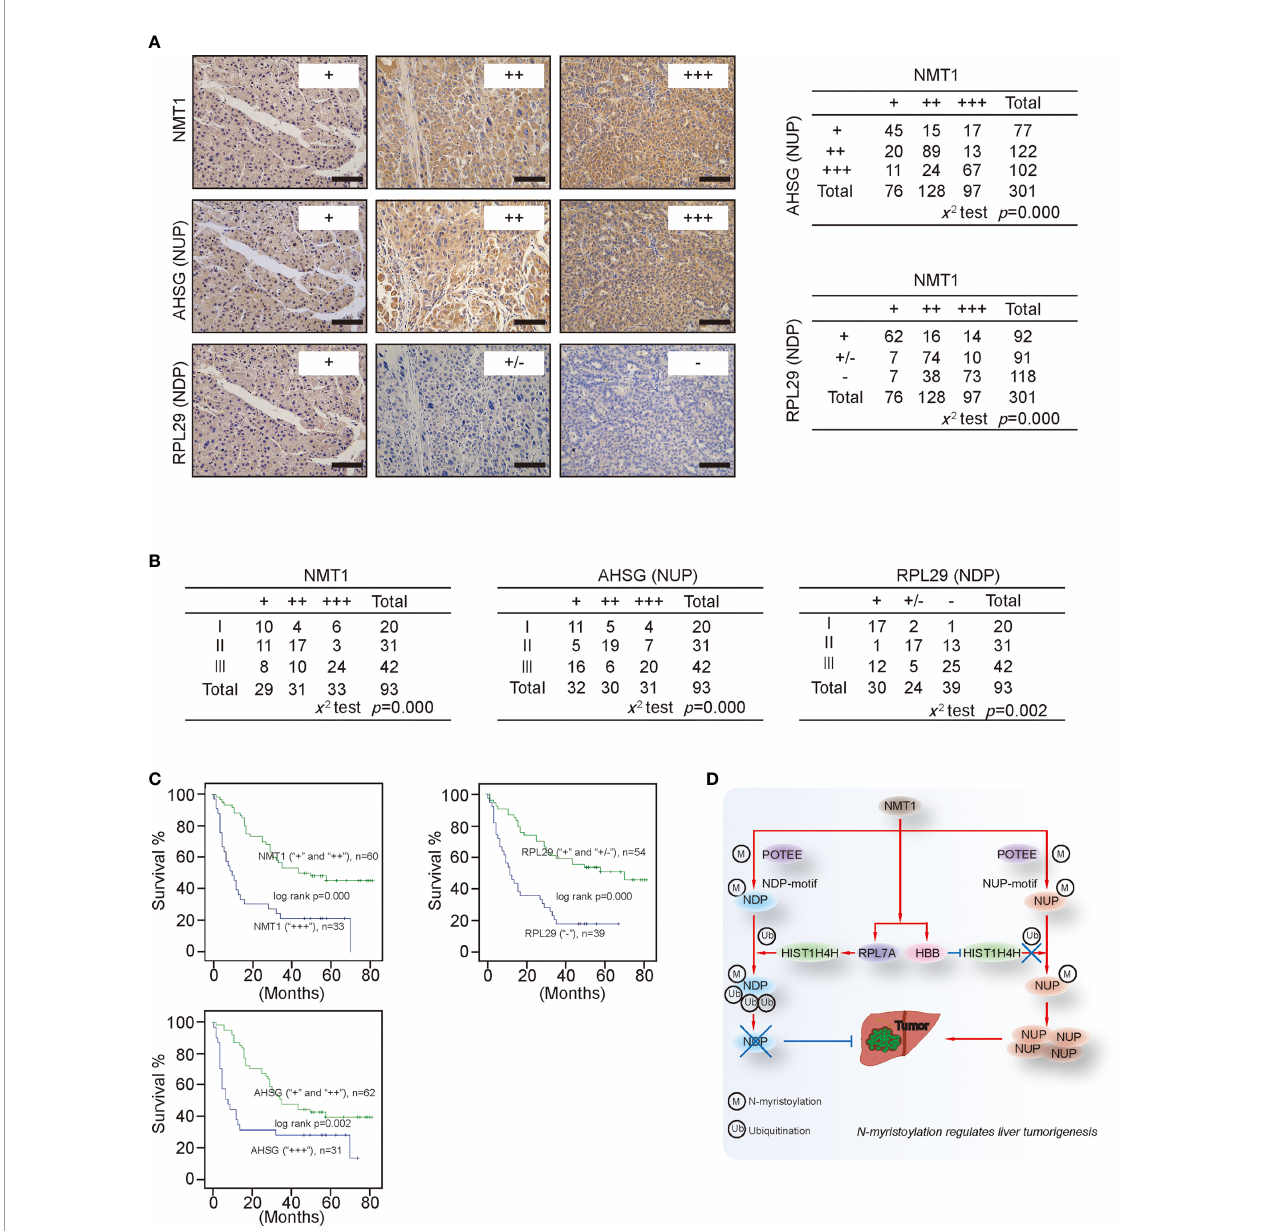
FIGURE 8 | Clinical signi fi cance of NMT1, NDP and NUP (A) Representative IHC images of NMT1, AHSG and RPL29 from liver cancer are shown. The relationship between NMT1 and AHSG, and between NMT1 and RPL29 were evaluated by X 2 test. Scale bar, 150 m m (B) The relationship between tumor stage and NMT1, AHSG or RPL29 was evaluated in liver cancer by X 2 test. (C) NMT1, RPL29 and AHSG affected survival. Patients bearing liver cancer with different expression of NMT1 ( “ + ” and “ ++ ” versus “ +++ ” ), RPL29 ( “ + ” and “ +/- ” versus “ - ” ) and AHSG ( “ + ” and “ ++ ” versus “ +++ ” ), as indicated, had different outcome of survival, as analyzed by the Kaplan-Meier curves and the log-rank test. (D) Schematic presentation of the possible mechanism underlying how NMT1 and N-myristoylation stimulate tumorigenesis in liver